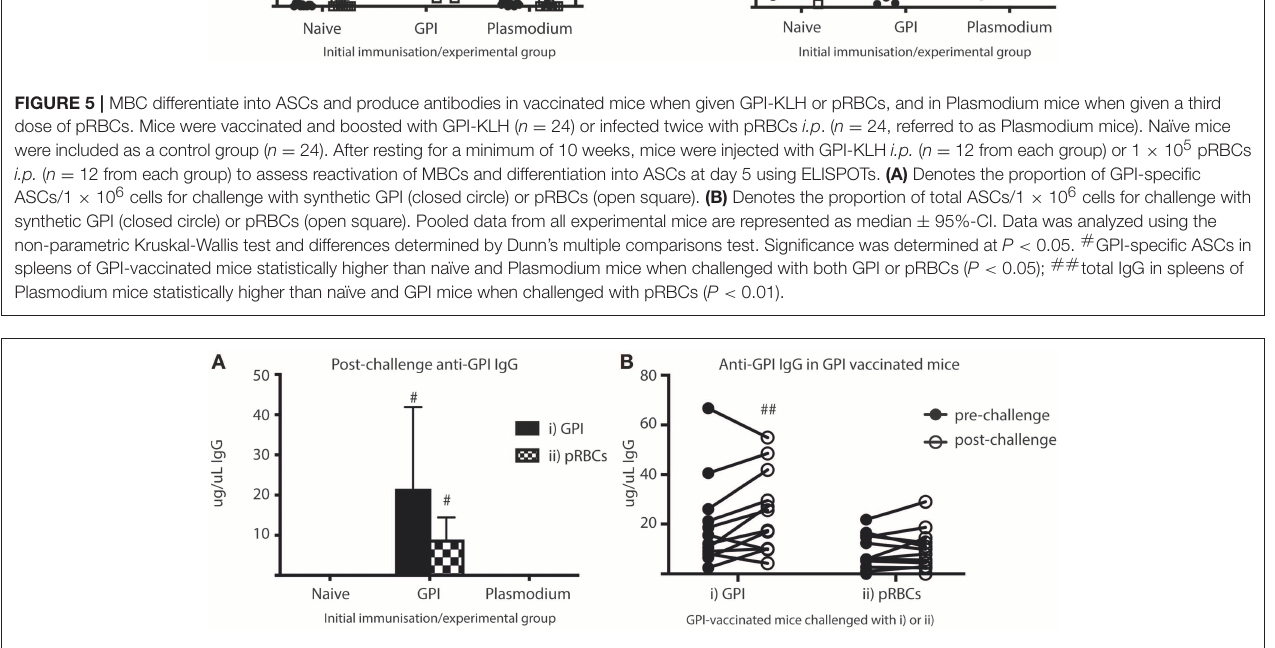
FIGURE 6 | Higher titers of anti-GPI IgG at day 5 in GPI-KLH mice following injection with synthetic GPI-KLH or pRBC compared to naïve or Plasmodium mice. Mice were vaccinated and boosted with GPI-KLH ( n = 24) or infected twice with pRBCs i.p . ( n = 24). Naïve mice were included as a control ( n = 24). Mice were rested for 10 weeks. Mice were subsequently challenged with GPI-KLH i.p. or 1 × 10 5 pRBCs i.p. and post-challenge sera collected from a cardiac bleed at day 5. (A) Day 5 titers were compared among groups to measure titers of anti-GPI IgG in response to GPI-KLH (filled bars; n = 12 from each group) or pRBCs (checked bars; n = 12 from each group). Pooled data from all experimental mice was analyzed using the non-parametric Kruskal-Wallis test and differences determined by Dunn’s multiple comparisons test. Significance was determined at P < 0.05. (B) In the GPI-KLH vaccinated group, sera samples were taken up to 7 days prior to challenge with GPI-KLH or pRBCs and titers measured (closed circles; pre-challenge). These titers were pair-matched to day 5 post-challenge titers (open circles; post-challenge) using the Paired Wilcoxon test to measure potential boosting of anti-GPI IgG in response to GPI-KLH or pRBCs. Significance was determined at P < 0.05. Data